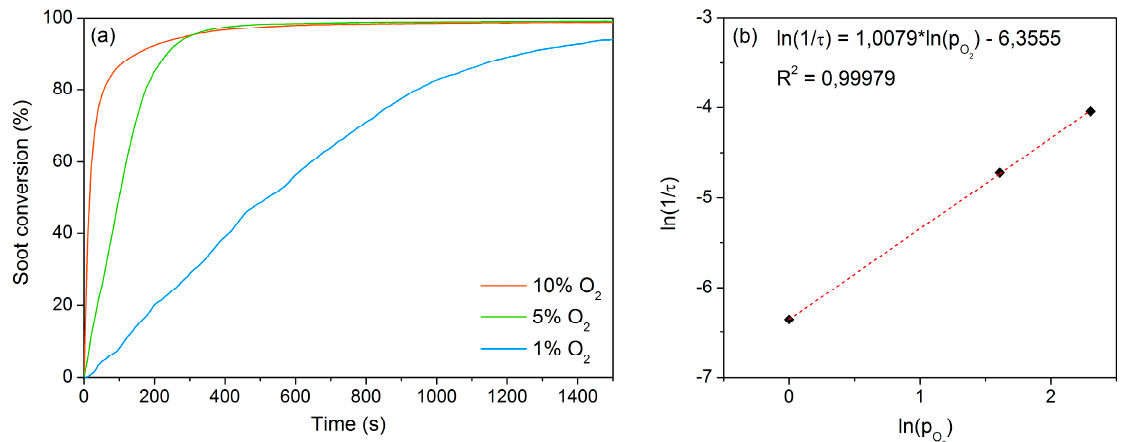
Figure 10. Soot conversion profiles as a function of time during the isothermal soot oxidation tests performed over the Ce50Pr50 catalyst in different O 2 conditions ( a ). Linear regression of the experimental data ( b ), as described in Equation (6).